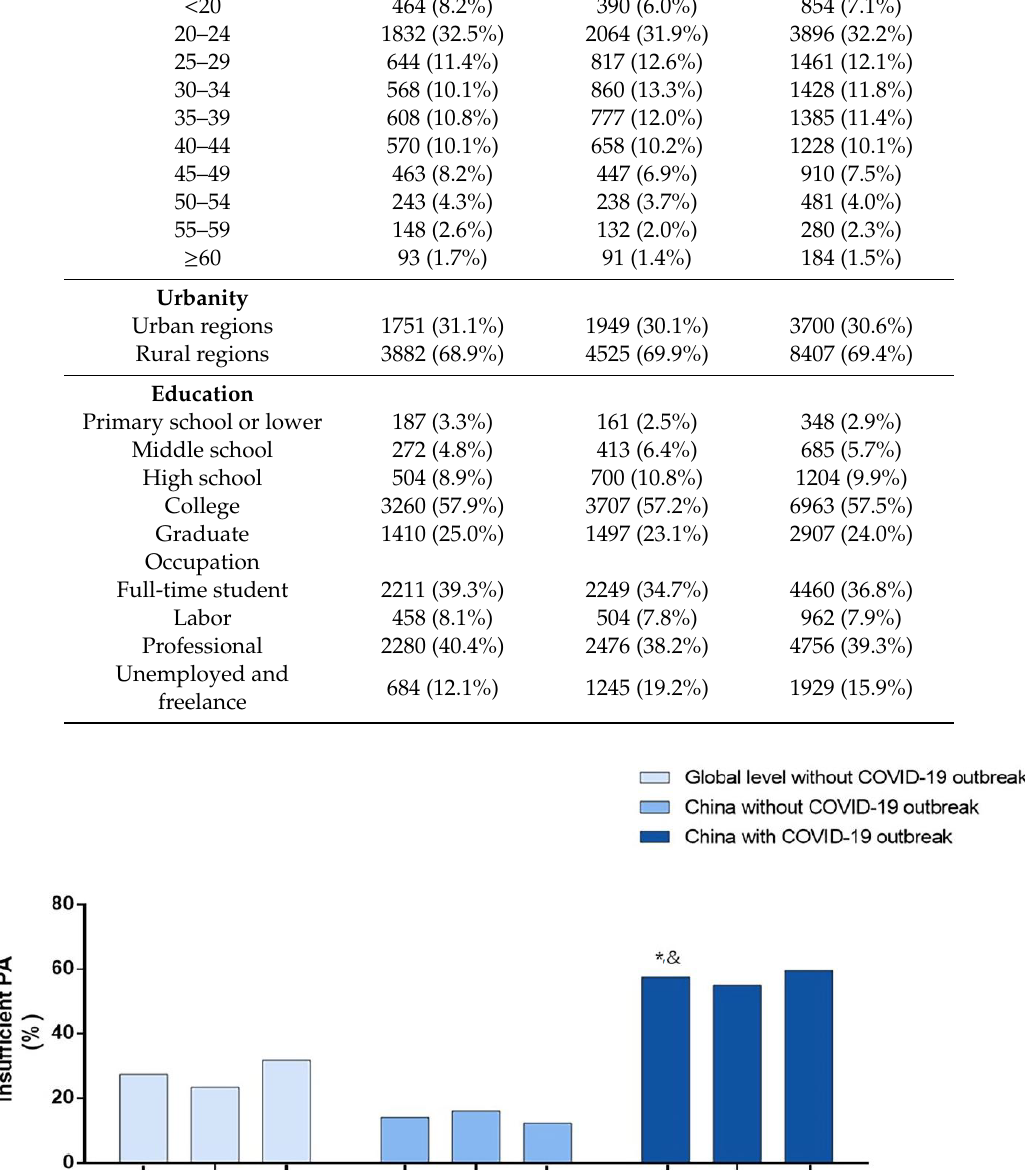
Figure 1. Prevalence of insufficient physical activity (PA) among Chinese adults aged 18 and over during COVID-19 epidemic period in China, compared with the national levels in China (during non-epidemic period) and the average global level (World Health Organization (WHO) data, without COVID-19 outbreak), among all participants, men, and women, separately. PA = physical activity. * p < 0.05 versus Global level; & p < 0.05 versus China without COVID-19 outbreak (non-epidemic period). The provincial prevalence of insufficient physical activity ranged from 48.9% in Beijing to 73.3% in Qinghai, the top five provinces being Qinghai, Xinjiang, Jilin, Heilongjiang, and Tibet. (Figure 2 and Table A3). In addition, focusing on two cities with serious epidemic situations, the prevalence of insufficient physical activity was 63.5% (53.8 – 73.1) in Wuhan, and 63.8% (58.2 – 69.1) in Wenzhou (Figure 2). Among men, four provinces had prevalence of insufficient activity over 71.0% (Jilin, Xinjiang, Tibet, and Qinghai) (Figure 2 and Table A3). Among women, the prevalence of insufficient physical activity was the highest in Qinghai, followed by Guangxi (Figure 2 and Table A3). By gender, the prevalence of insufficient physical activity among men (55.1%, 53.8 – 56.4) was significantly lower than among women (59.5%, 58.2 – 60.7) during home quarantine (  2 = 29.51, p < 0.0001; Table 2). In addition, the rate of participation in vigorous activity was higher among men